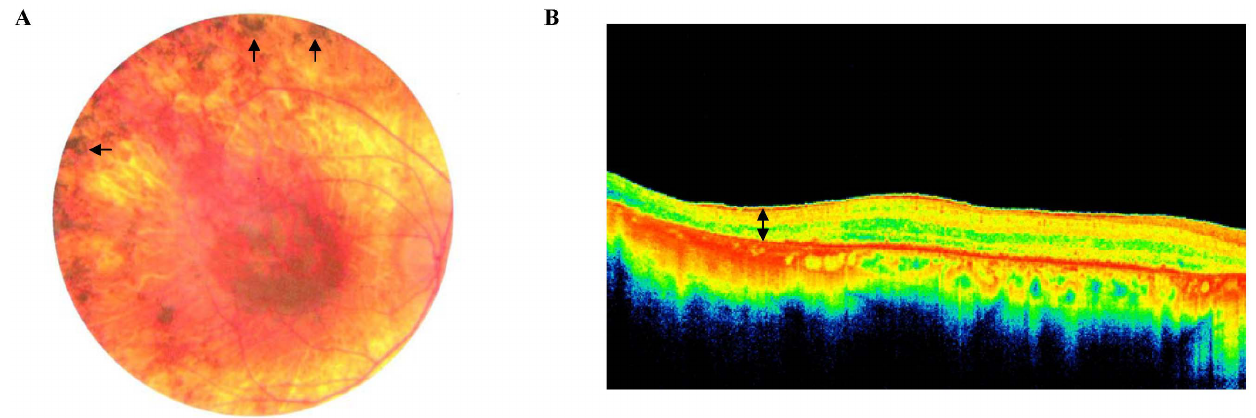
Figure 1. Clinical examination. A. Posterior pole of the right eye of patient USHLB13-II.3 showing atrophy of the retina and choroid with pigment spicules (arrows) anterior to the arcades. B. Spectral domain optical coherence tomography of the right eye of the same patient showing significant thinning of the retina (space delineated by double arrow) compared to normal controls.